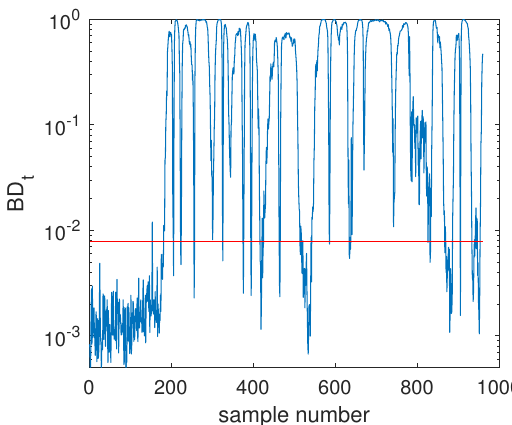
Figure 7. Fault detection chart of fault F10 based on one ensemble deep SVDD (EDeSVDD).